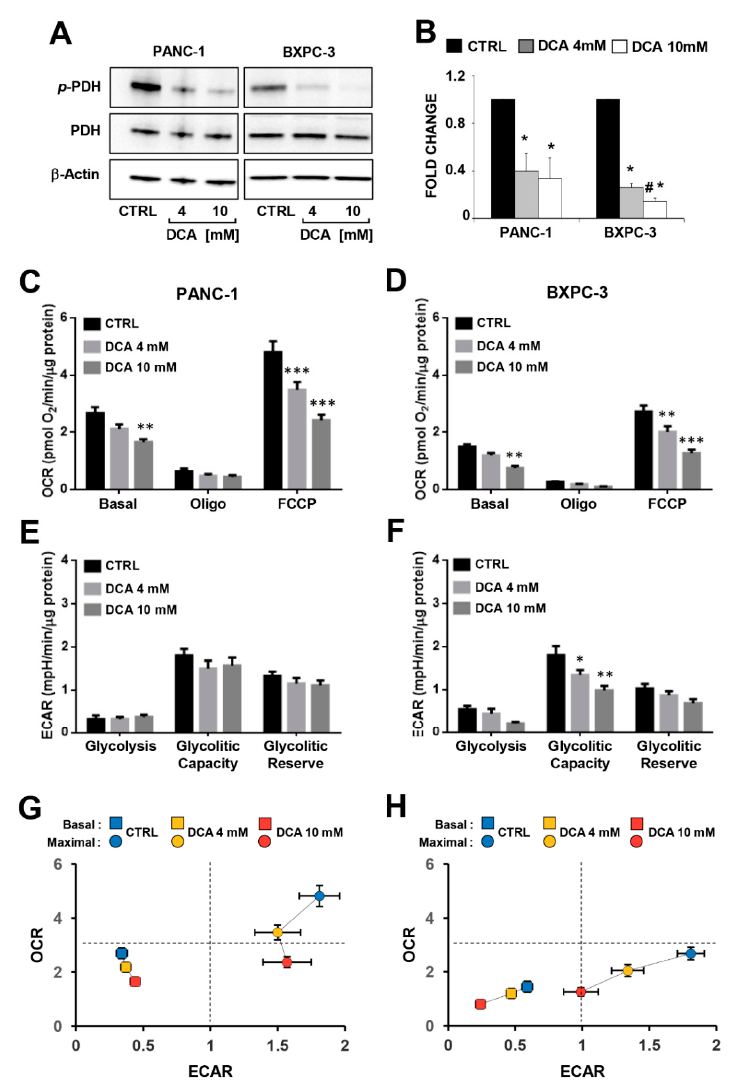
Figure 3. Effect of DCA on pyruvate dehydrogenase E1-alpha (PDH) phosphorylation and metabolic fluxes, ( A ) a representative immunoblotting of the phospho-S293 E1 α PDH (pPDH) and total enzyme subunit in PANC-1 and BXPC-3 cells following 24 h incubation with DCA 4 mM and 10 mM, β -actin was used as loading control; ( B ) quantitative analysis of the densitometric values of phospho-S293 E1 α PDH relative to total PDH, normalized to β -actin, the results are the means ± SEM of three independent experiments, * p < 0.05 vs. CTRL, # p < 0.05 vs. BXPC-3 DCA 4 mM; ( C , D ) oxygen consumption rate (OCR) performed by the SeaHorse platform as described in the Material and Method section and normalized to the protein content of the cells at the end of the assay, basal: resting OCR; oligo: OCR measured after the addition of the ATP synthase inhibitor oligomycin; FCCP: OCR measured after the uncoupler FCCP producing the maximal respiratory capacity, the OCR was corrected for the residual OCR measured after the addition of the CxI inhibitor rotenone (not shown); ( E , F ) extracellular acidification rate (ECAR) measured in PANC-1 and BXPC-3 treated with DCA 4 mM and 10 mM for 48 h, glycolisis: resting ECAR; glycolitic capacity: ECAR measure after the addition of olygomycin and FCCP and refers to maximal glycolytic activity with the OxPhos inhibited; glycolytic reserve: di ff erence between ECAR measured in the presence of oligomycin + FCCP and under resting conditions, the bars represent the means ± SEM of 3 independent experiments carried out in 3 technical replicates under each condition (* p < 0.05, ** p < 0.01, *** p < 0.001 vs. respective CTRL); ( G , H ) energy maps obtained plotting basal and maximal ECAR and OCR capacities obtained in PANC-1 and in BXPC-3,